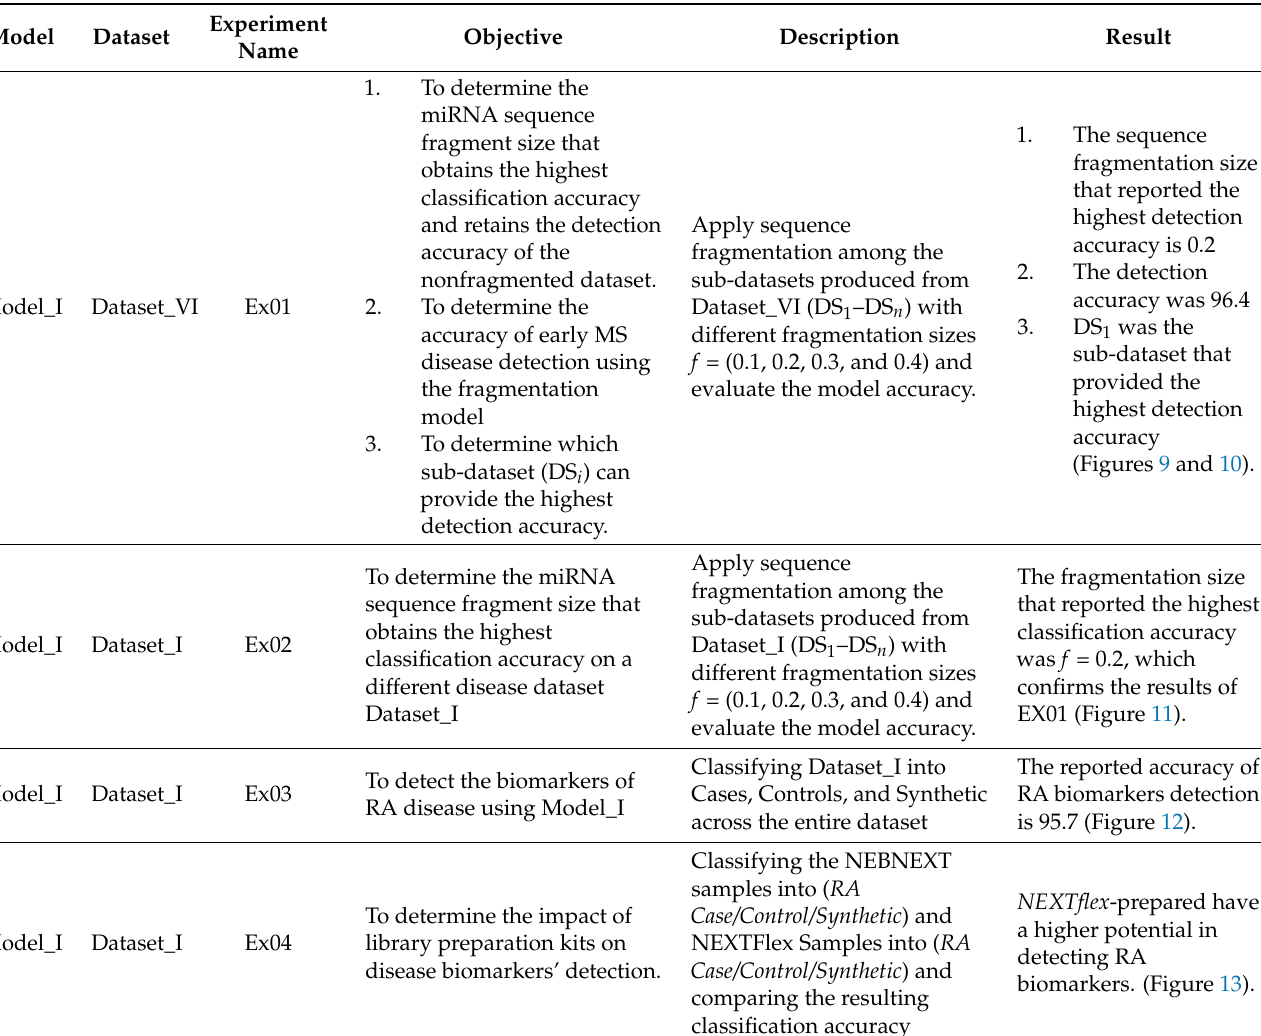
Table 4. Summary of the conducted experiments and